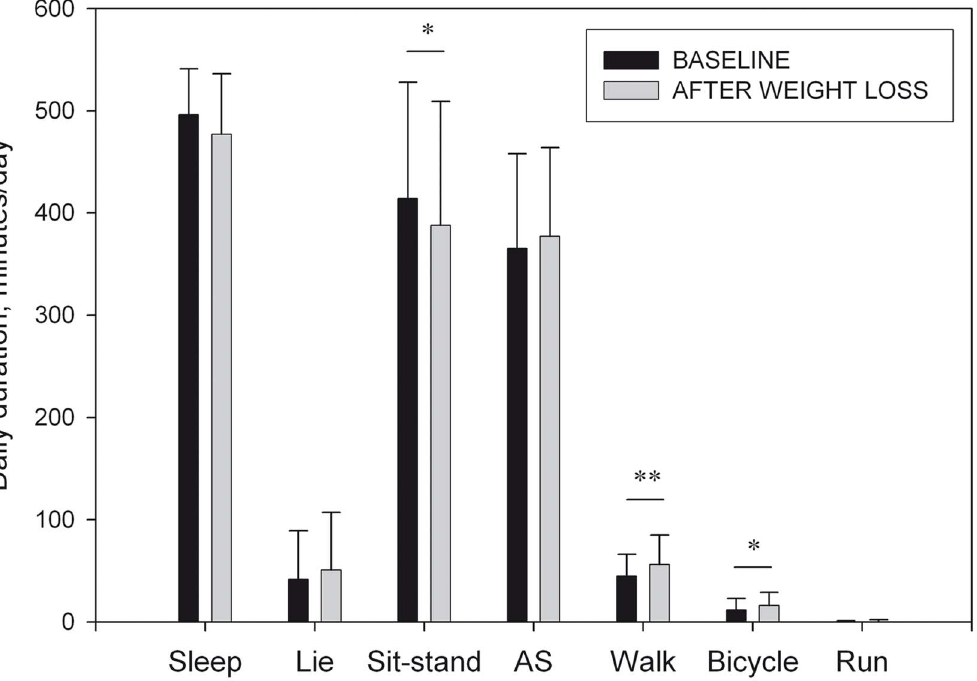
Figure 3. Duration of the types of activity performed at baseline and after weight loss. Sit-stand; daily duration of sitting and standing still. AS; daily duration of actively standing. (*) or (**); significant difference between baseline and after weight loss (P , 0.05 or P ,